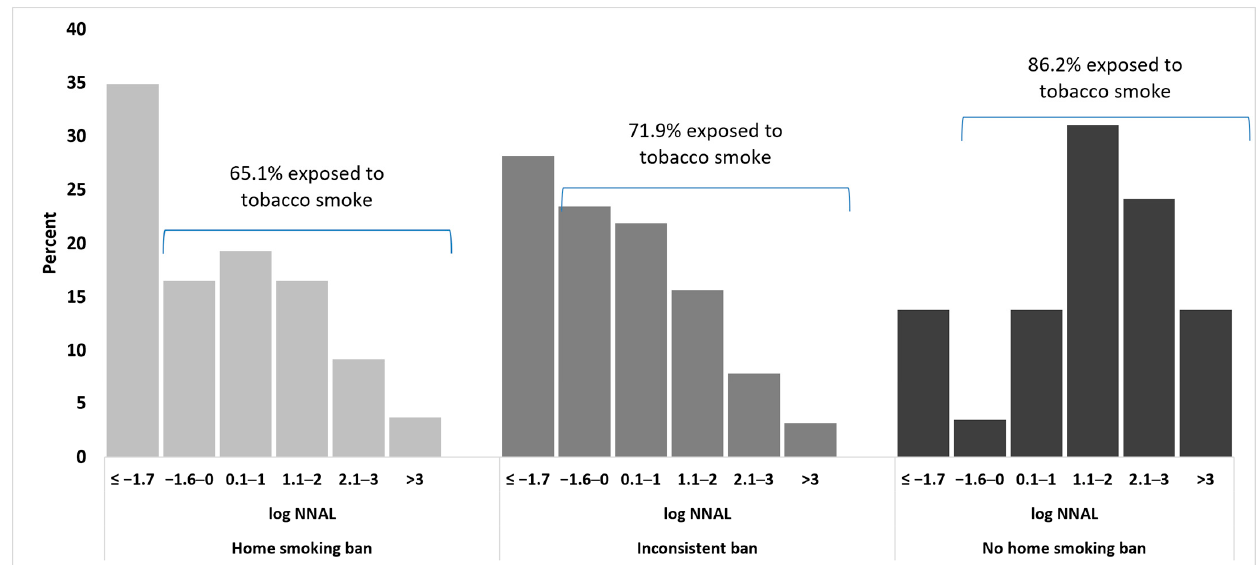
Figure 1. Distribution of nonsmoker NNAL (pg/mg) on the natural log scale by home smoking ban category. Among nonsmokers with detectable levels of NNAL, Table 2 describes self-reports of tobacco smoke exposure across various settings in the past two months. For nonsmok- ers with a home smoking ban, almost one-quarter reported tobacco smoke exposure in the home, the second highest source after outdoors. For nonsmokers with an inconsistent ban, less than one-third reported tobacco smoke exposure in the home, the second highest source after outdoors. For nonsmokers with no home smoking ban, over half reported tobacco smoke exposure in the home, the highest reported source. Nearly three-quarters (73.6%) of nonsmokers with a ban or inconsistent ban reported outdoor tobacco smoke exposure, compared with about one-third of nonsmokers with no home smoking ban. Be- tween 10% and 20% of nonsmokers with a home smoking ban or inconsistent ban reported tobacco smoke exposure in settings other than inside the home and outdoors, while 20%– 30% of nonsmokers with no home smoking ban generally reported tobacco smoke expo- sure in these other settings. Table 2. Self-reported past 2 month tobacco smoke exposure settings among nonsmokers with de- tectable NNAL levels ( n = 143). Setting